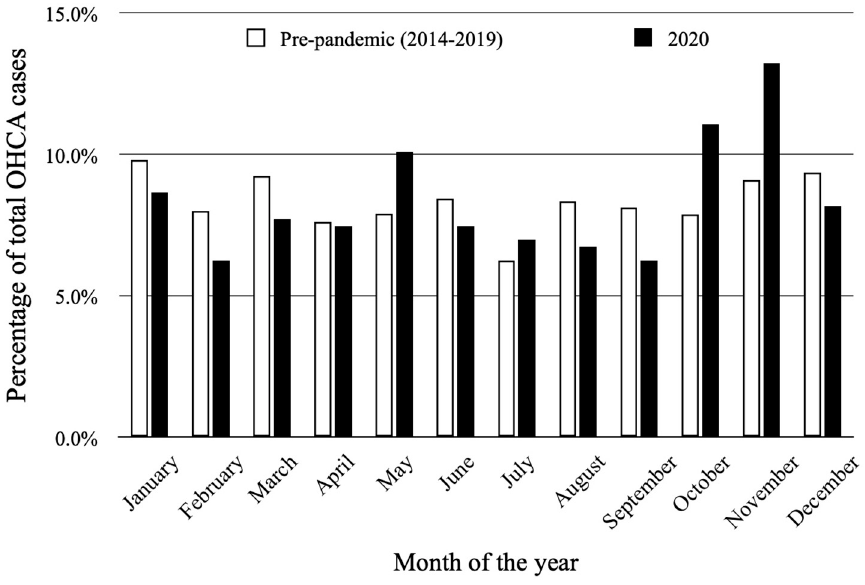
Figure 4. Monthly distribution of out-of-hospital cardiac arrest (OHCA) occurrence in year 2020 ( p = 0.017) and during 2014–2019 pre-pandemic period ( p = 0.009).